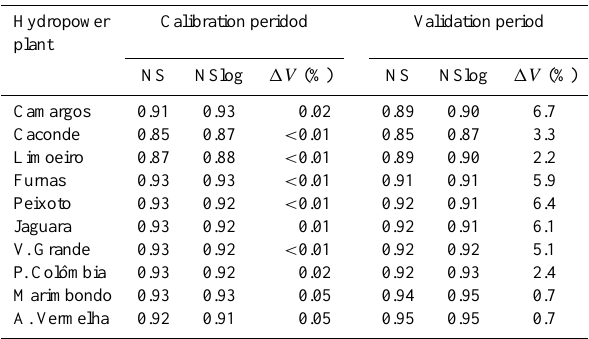
Table 1. Skill metrics of the hydrological model run with observed precipitation data during the calibration (1970–1980) and validation (1981–2001) periods (NS: Nash-Sutcliffe coefficient of efficiency of daily discharge values; NSlog: Nash-Sutcliffe coefficient of ef- ficiency of the logarithms of daily discharge values; 1V : volume